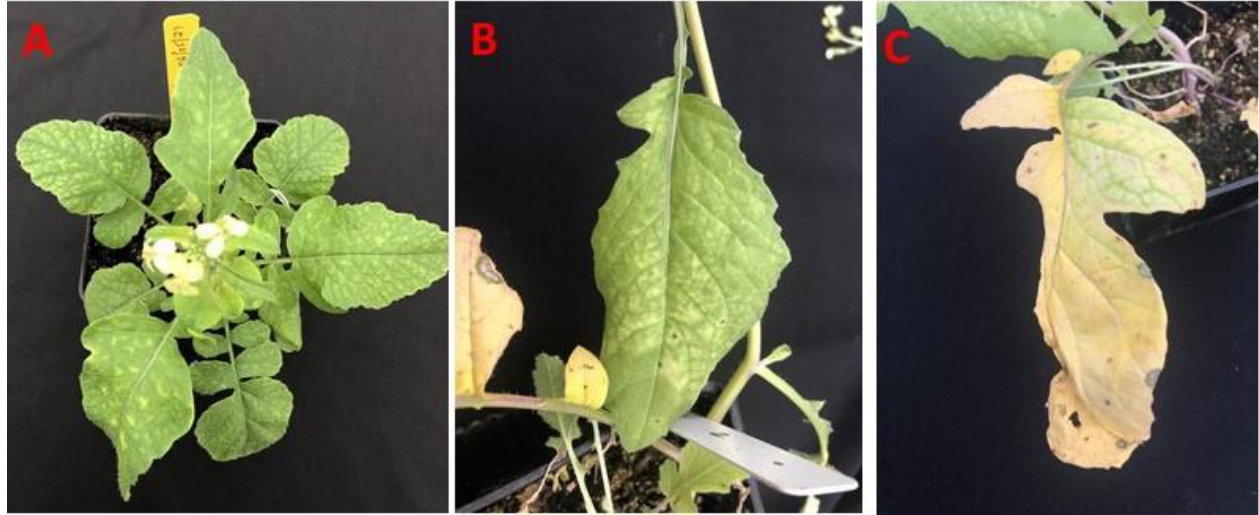
Figure 3. Symptoms induced by cucurbit chlorotic yellows virus on wild radish ( Raphanus raphanistrum): mild yellowing at 2 weeks after inoculation ( A ); interveinal chlorosis ( B ); late symptoms yellowing and drying of lower leaves ( C ). Table 2. Infection of wild radish with cucurbit chlorotic yellows virus (CCYV) and back transmission to cucurbit hosts. Wild radish infected with CCYV were used as source plants for back transmissions to cucurbit hosts. Virus infections on inoculated plants were determined by RT-qPCR 3 weeks after